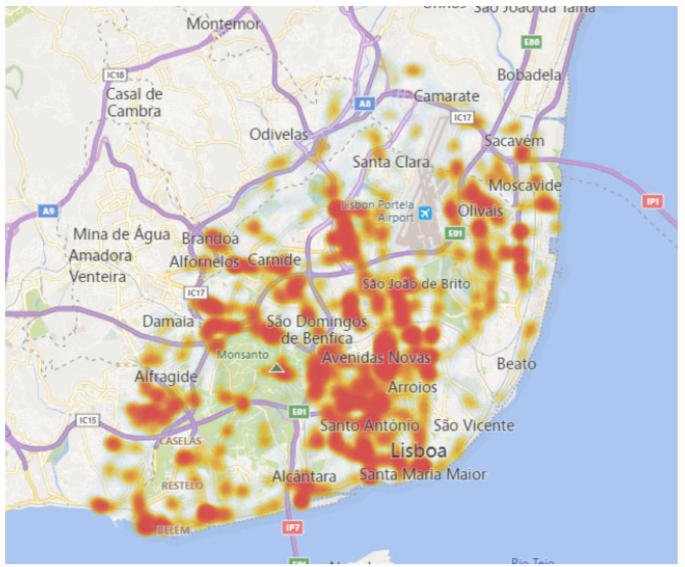
Figure 5. Distribution of traffic on primary streets in Lisbon in 2019. Red corresponds to locations where more traffic congestion occurred on primary streets; orange and yellow are locations where traffic congestion was less common on primary